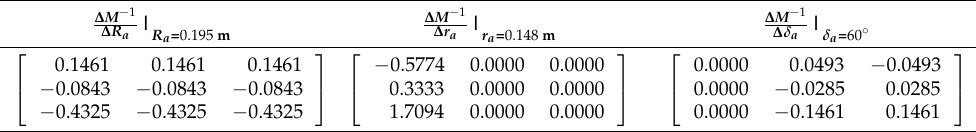
Table 1. Sensitivity of M − 1 to the values of the nominal kinematic parameters of the wheel a .